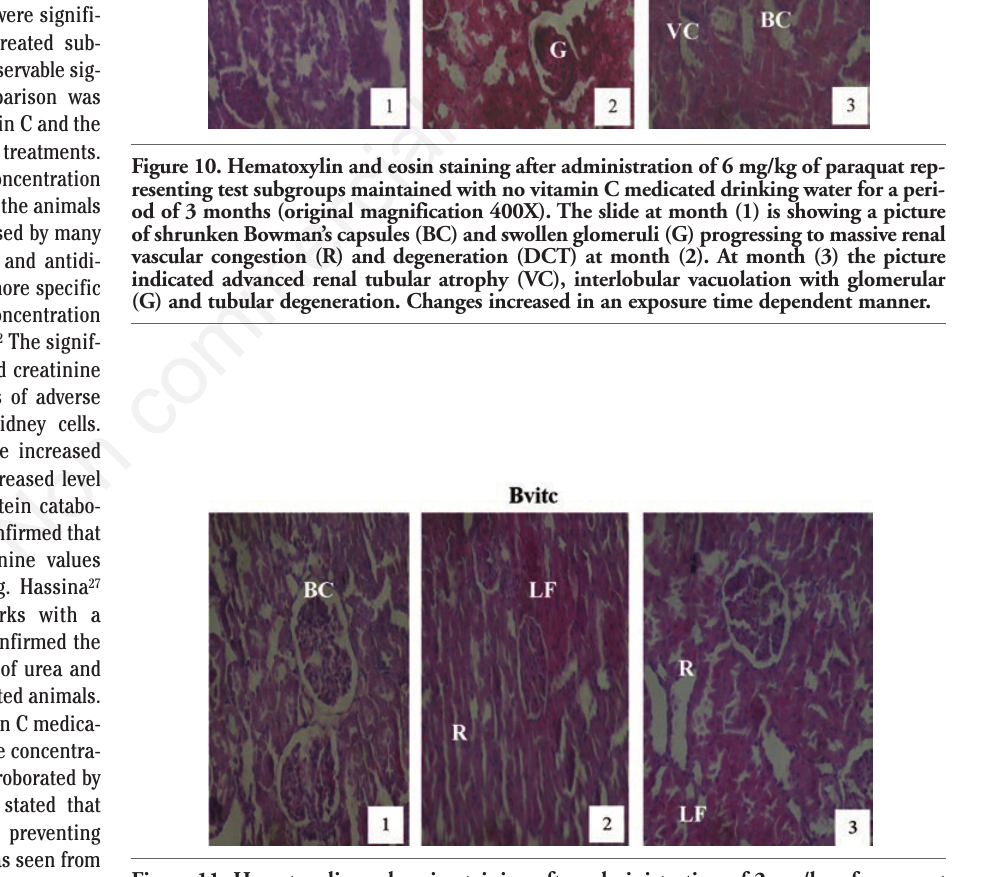
Figure 11. Hematoxylin and eosin staining after administration of 2 mg/kg of paraquat representing test subgroups maintained with vitamin C medicated drinking water (1 g/L) for a period of 3 months (original magnification 400X). The slide at month (1) is show- ing a picture of shrunken Bowman’s capsules (BC) and swollen glomeruli progressing to renal vascular congestion (R) and leucocyte infiltrations (LF) at month (2). At month (3) the picture indicated advanced renal tubular hypertrophy (R), leucocytes infiltrations (LF), interlobular vacuolation with glomerular and tubular degeneration. Changes increased in an exposure time dependent